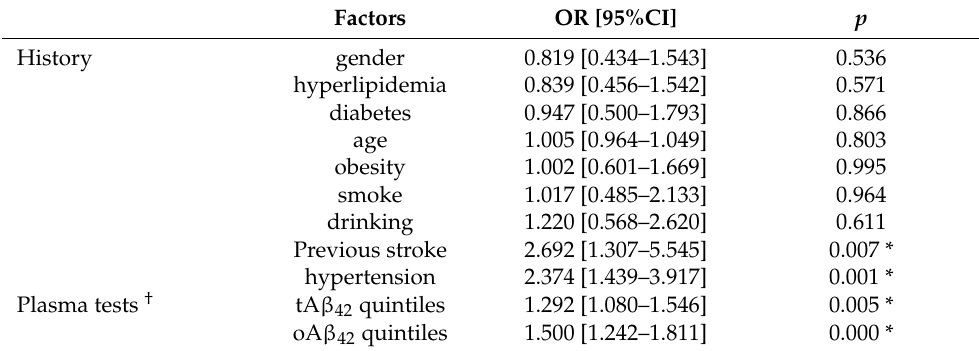
Table 3. Independent factors for the presence of CSVD.